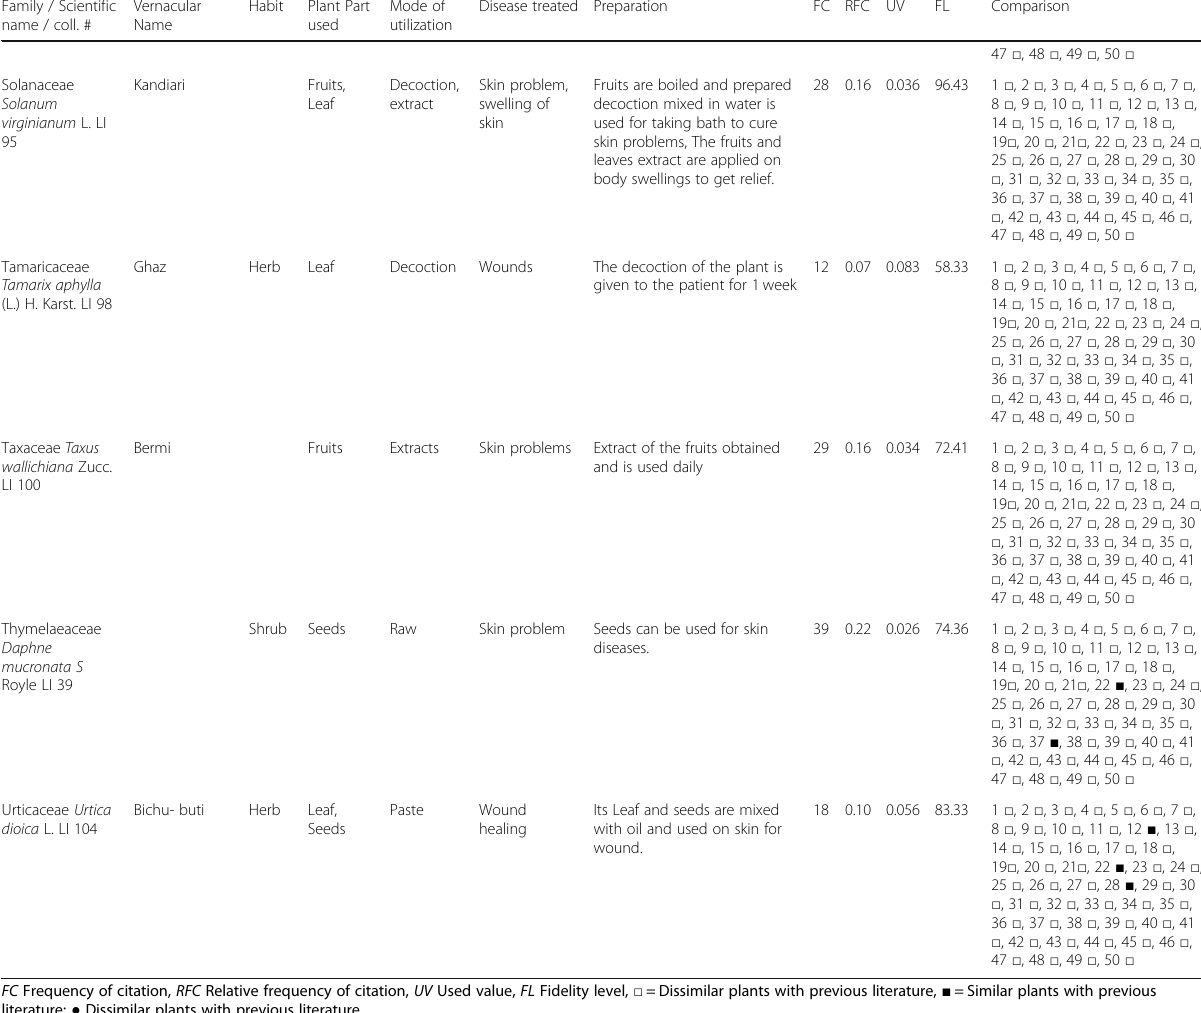
Table 2 Medicinal plants used for skin diseases in Northern Pakistan (Continued) Family / Scientific name / coll.